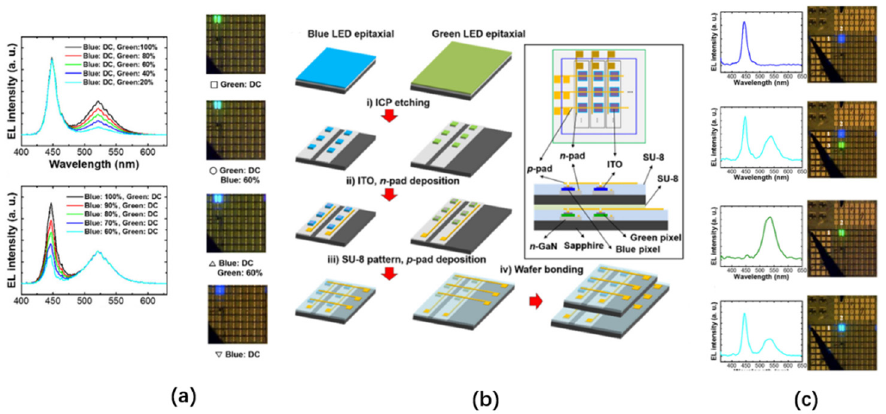
Figure 2. ( a ) Electroluminescence (EL) spectra measured by changing the Pulse width modulation (PWM) duty ratios of the green sub-pixels and blue sub-pixels, and microscope images at the same pixel positions of the micro-LED array under different PWM duty ratios; ( b ) manufacturing steps of vertically stacked passive matrix micro-LED arrays; ( c ) four emission modes of vertically stacked passive matrix micro-LED arrays. Reproduced from [33], The Optical Society, 2017.